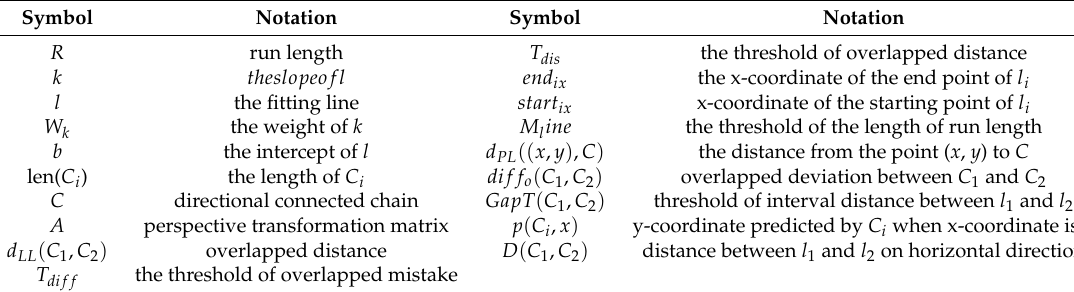
Table 1. The notations of